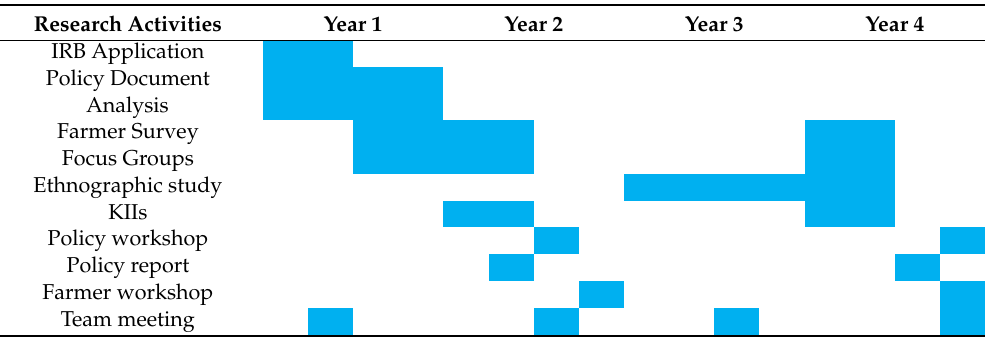
Table 1. Timeline of research